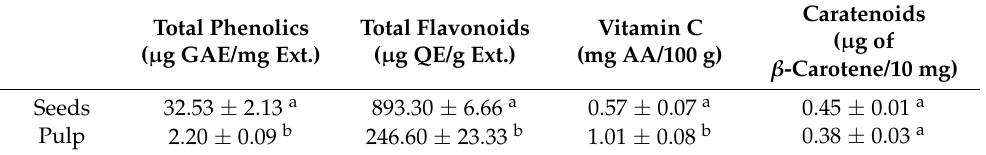
Table 1. Total phenols and total flavonoids quantification from A. squamosa seeds and pulp. Caratenoids Total Phenolics Total Flavonoids Vitamin C ( µ g of ( µ g GAE/mg Ext.) ( µ g QE/g Ext.) (mg AA/100 g) β -Carotene/10 mg) Seeds 32.53 ± 2.13 a 893.30 ± 6.66 a 0.57 ± 0.07 a 0.45 ± 0.01 a Pulp 2.20 ± 0.09 b 246.60 ± 23.33 b 1.01 ± 0.08 b 0.38 ± 0.03